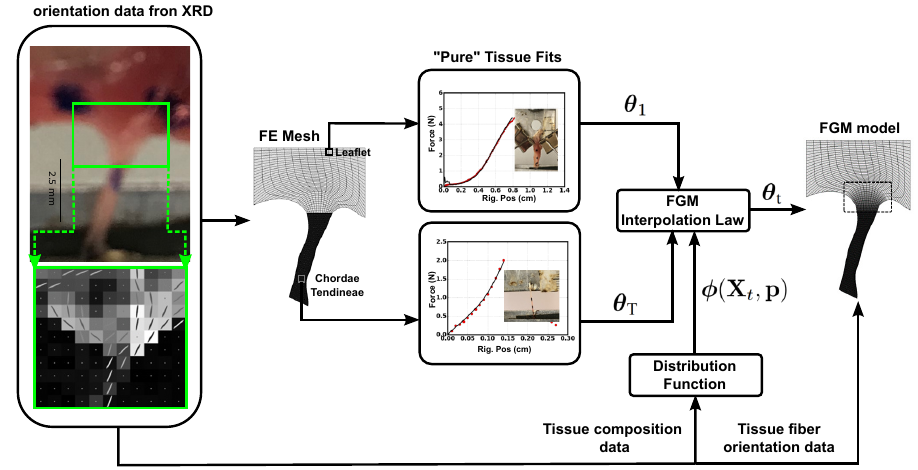
Figure 1. Overview of the proposed functionally graded material (FGM) modeling